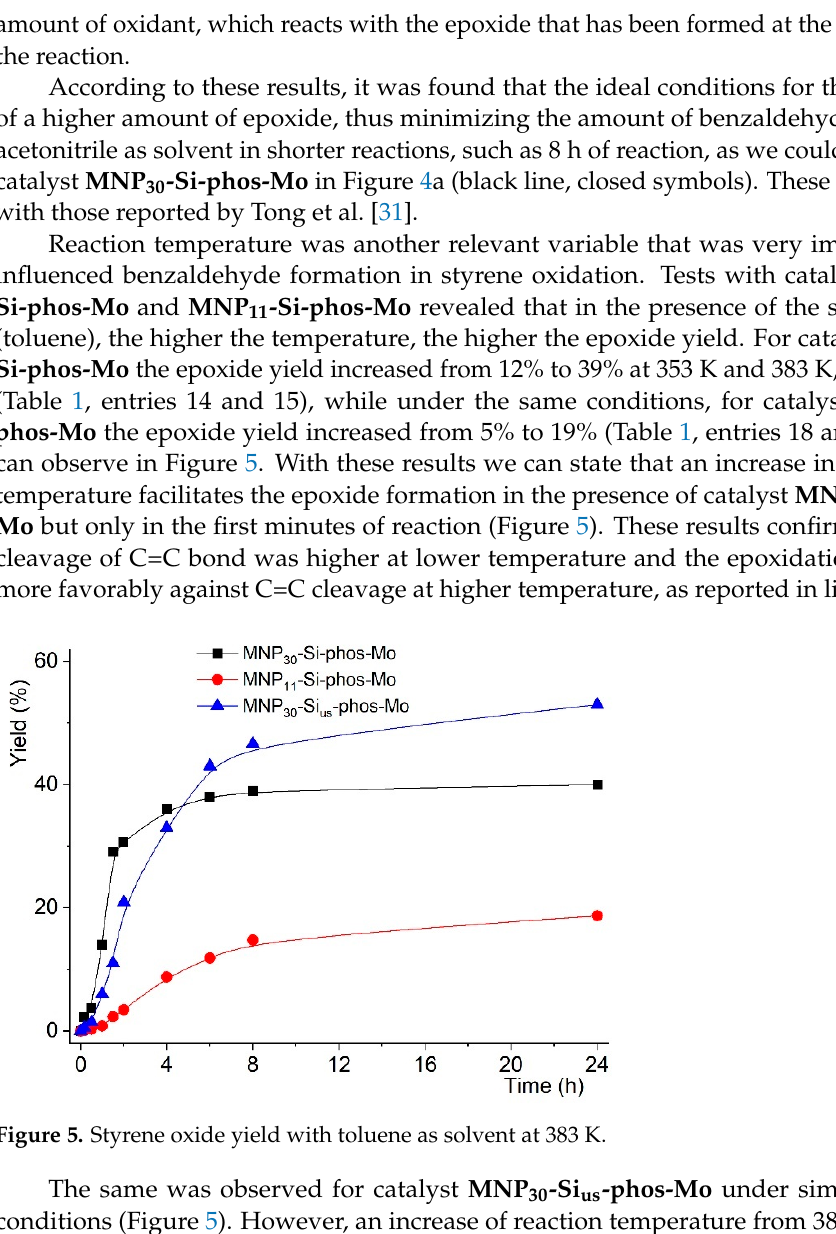
Figure 4. Styrene oxide (closed symbols) and benzaldehyde yield (open symbols) with acetonitrile ( a ) and toluene ( b ) as solvents at 353 K.